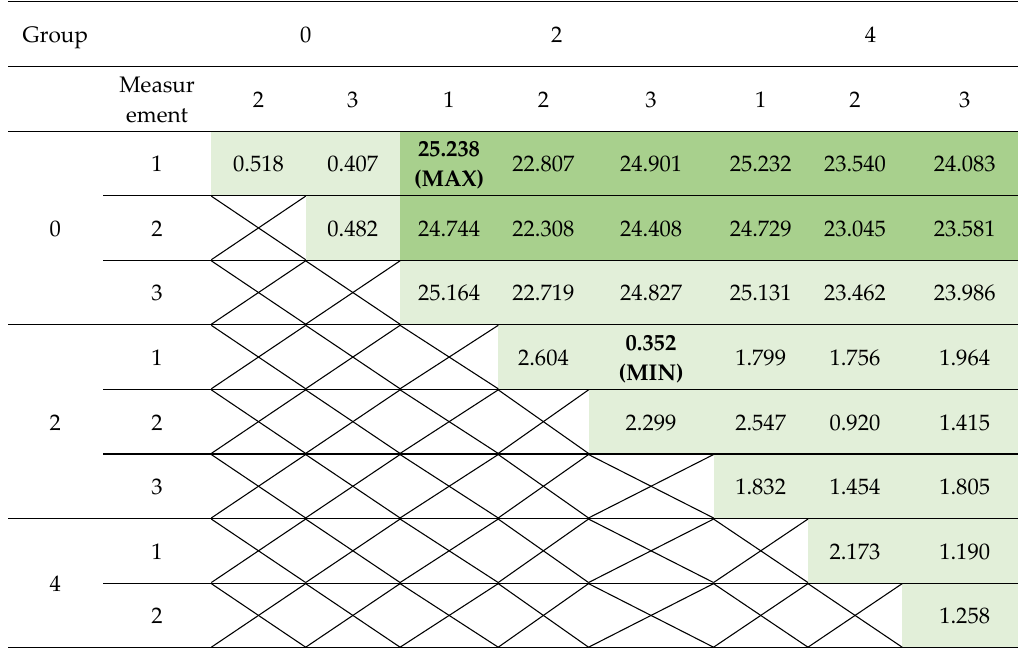
Table 8. Nanocomposite colour change analysis.